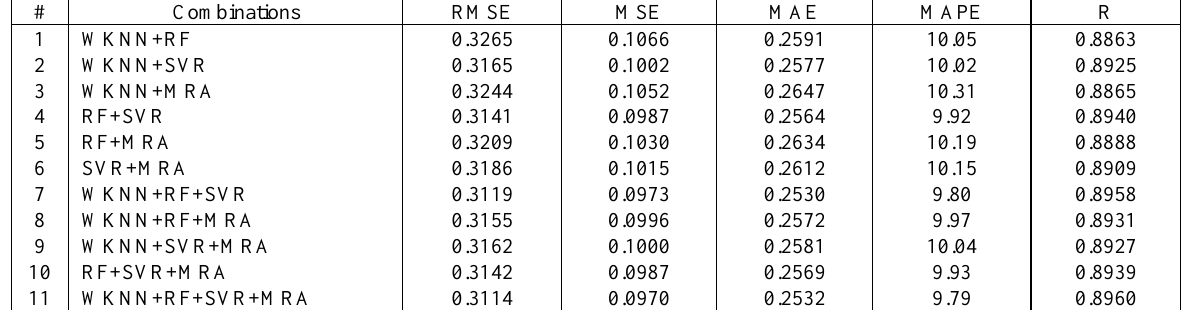
Table 4 . Evaluation criteria of the uncertainty modelling based upon the Stacking technique